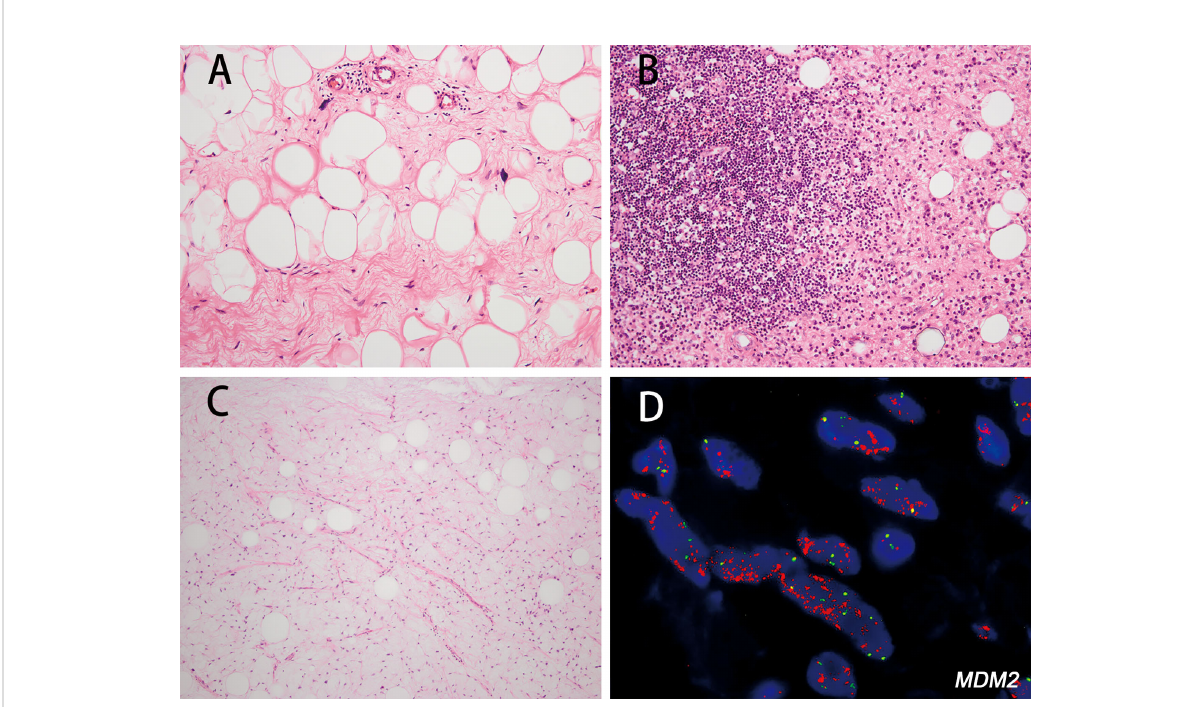
FIGURE 1 The histologic features of well-differentiated liposarcoma (WDL) and corresponding fl uorescence in situ hybridization (FISH) images. Lipoma-like WDL showing variation in adipocyte size, with the presence of bizarre, hyperchromatic stromal cells ( A hematoxylin and eosin staining [H&E]; magni fi cation: 200×). In fl ammatory WDL with predominant in fl ammatory cell arrogation and atypical, hyperchromatic cells can be identi fi ed in the stroma ( B H&E; magni fi cation: 200×). WDL with extensive myxoid change showing abundant myxoid stroma and containing small branching vessels ( C H&E; magni fi cation: 200×). FISH analysis identi fi ed MDM2 ampli fi cation in the WDL (case 17) (D)